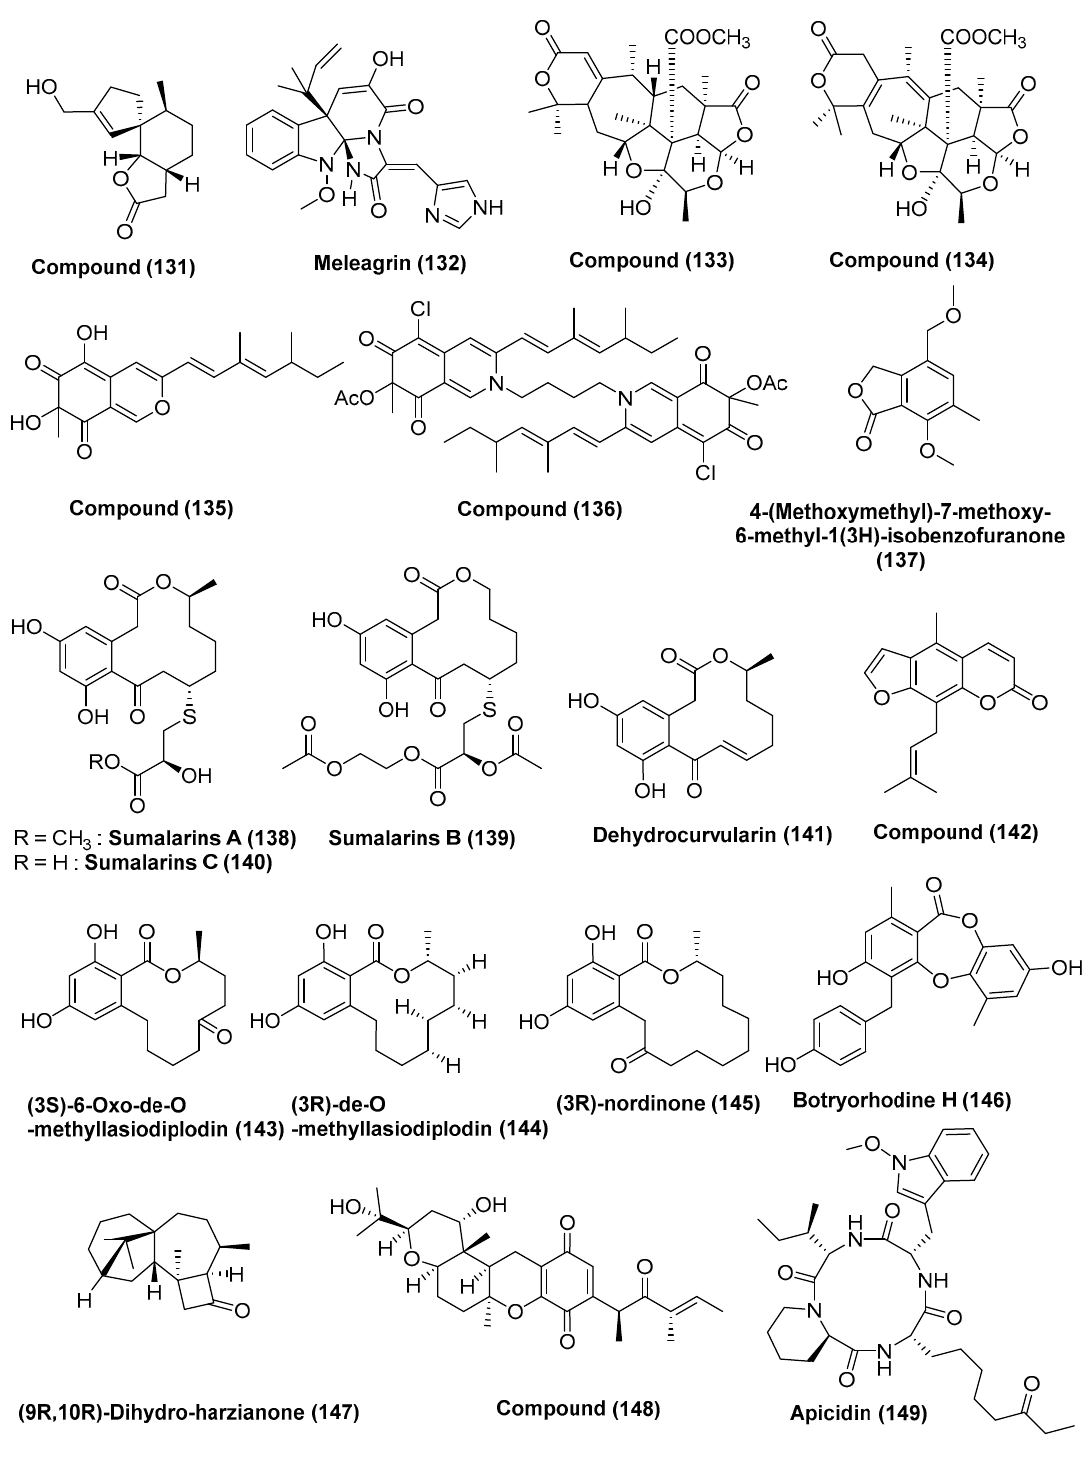
Figure 8. Structures of metabolites isolated from Hyphomycetes ( 131 – 149 ).